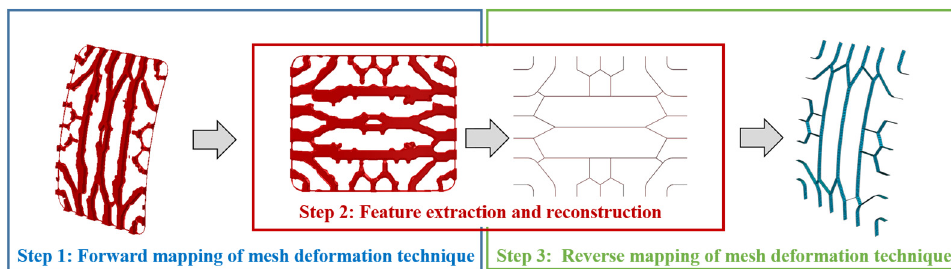
Figure 8. Schematic diagram of feature extraction and geometric reconstruction process.